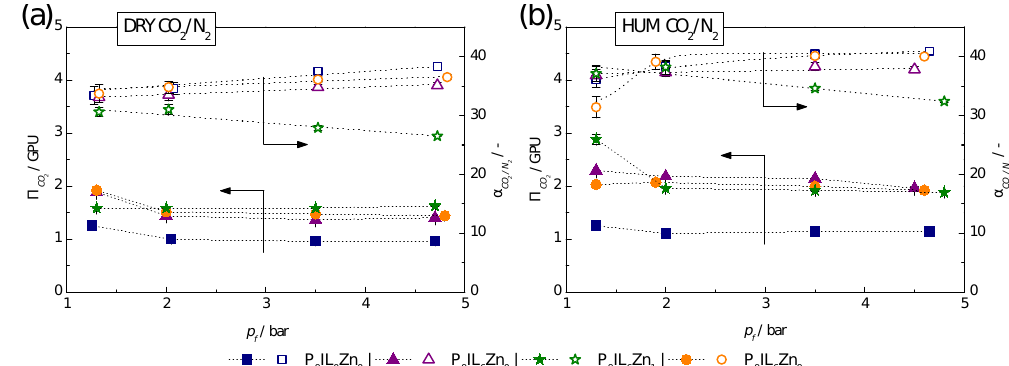
Figure 8. Influence of the feed pressure on the separation performance of PIL/IL/Zn 2+ composite-based TFC membrane at 26 ◦ C in dry ( a ) and humidified ( b ) conditions of the sweep test set-up. The relative humidity of feed gas was ca. 90% for humidified